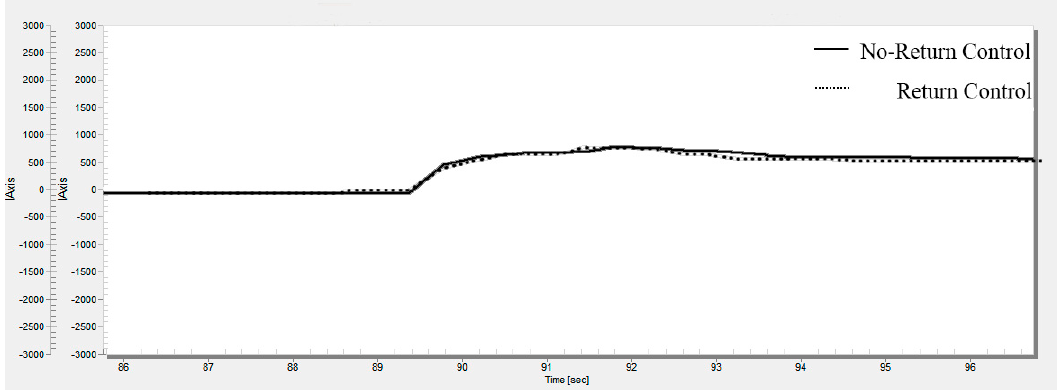
Figure 9. Assist characteristic test.